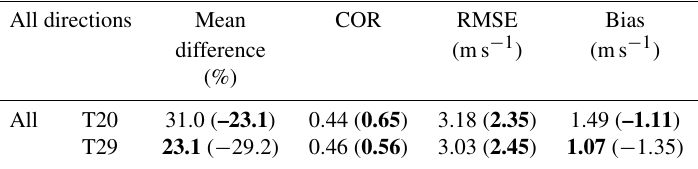
Table 5. As in Table 4 but for comparison of WRF simulations with tower T20 (tse04) and T29 (tse13) on the SW and NE ridge,